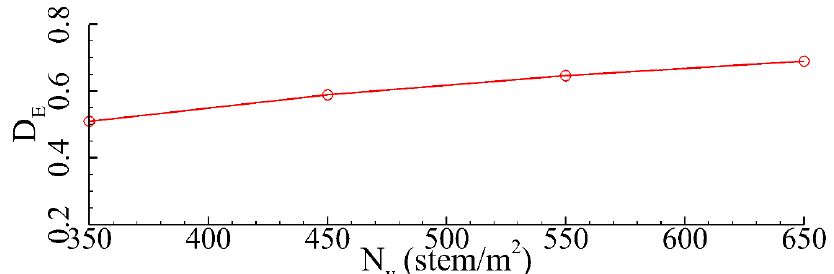
Figure 27. Dissipation rate of the wave energy under different vegetation densities.